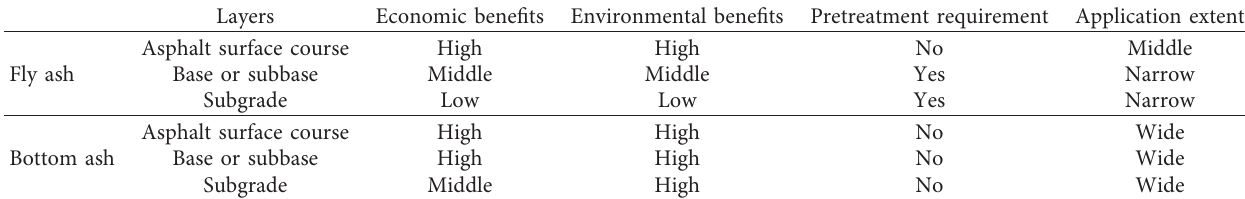
Table 7: Comparison of economic and environmental